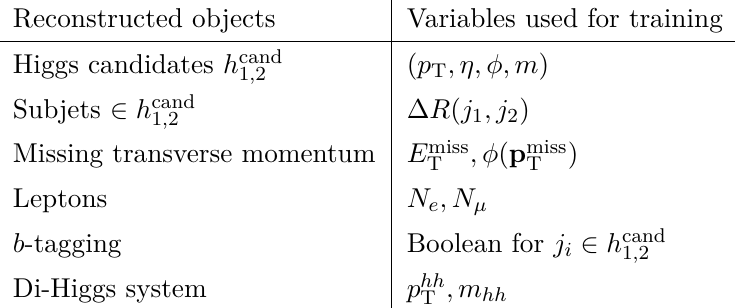
Table 3. Input variables used to train the neural